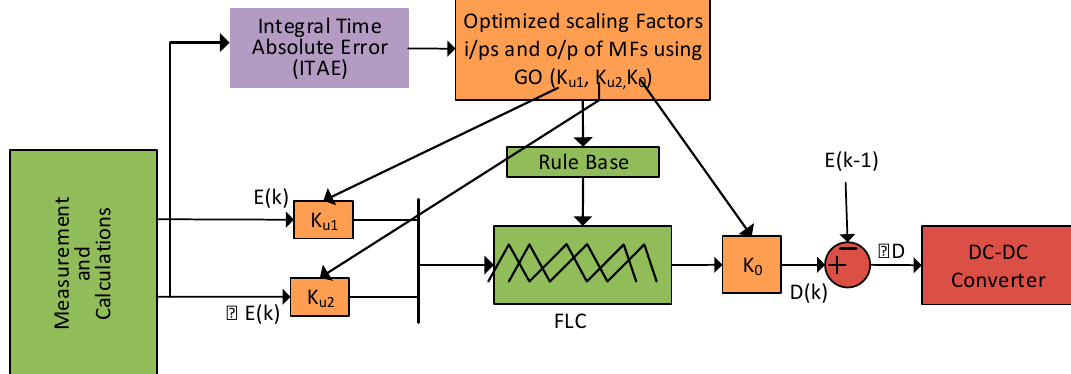
Figure 29. Grasshopper adaptive fuzzy logic controller. Abbreviations: MFs, membership functions.